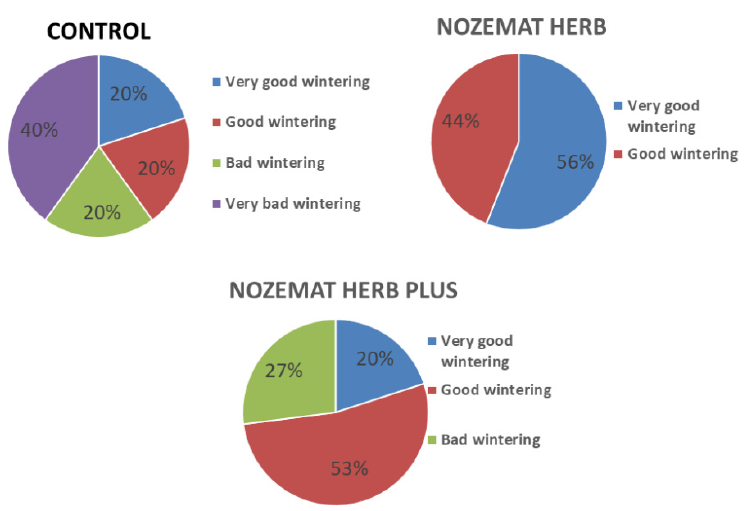
Figure 1. Honey colony overwintering (%) after application of herbal supplements NOZEMAT HERB ® and NOZEMAT HERB PLUS ® .